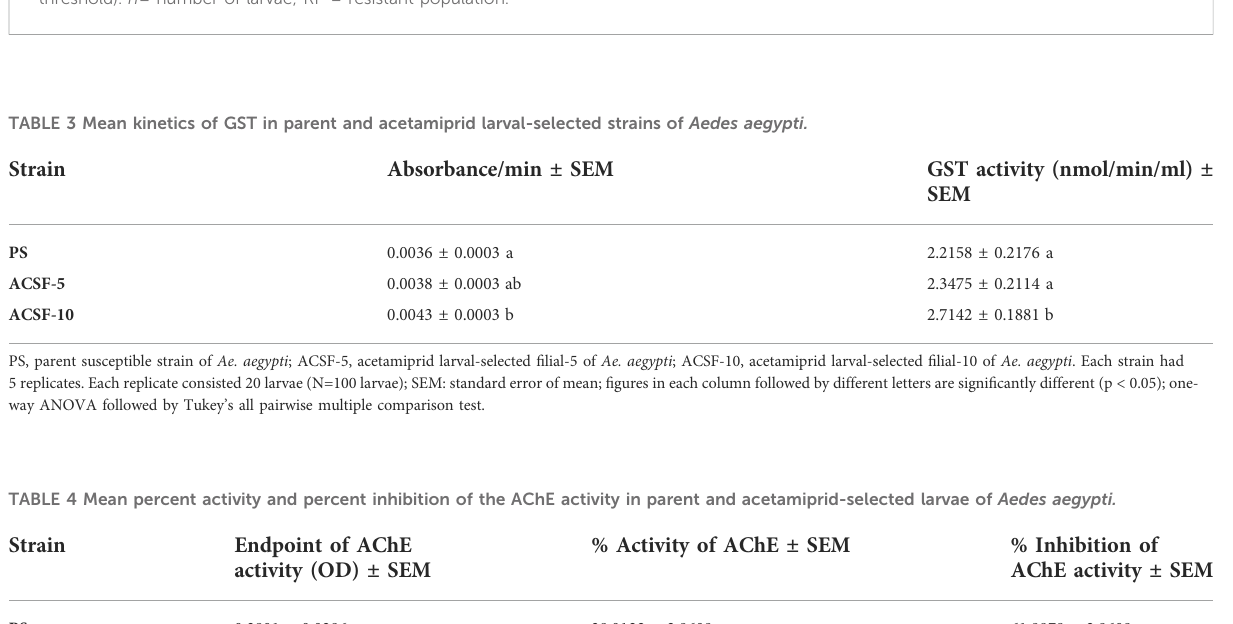
FIGURE 3 Frequencydistributionsofabsorbancevalue(570nm)asthe β -esteraseactivity(nmol/min/mgofprotein)inthelarvaeofPS(parentsusceptible strain), ACSF-5 (acetamiprid larval-selected fi lial-5), and ACSF-10 (acetamiprid larval-selected fi lial-10) strains of Aedes aegypti ( n = 100). The susceptibility threshold is based on the maximum absorbance in the PS strain. The shaded region represents the resistant population (beyond the threshold). n = number of larvae; RP = resistant population.